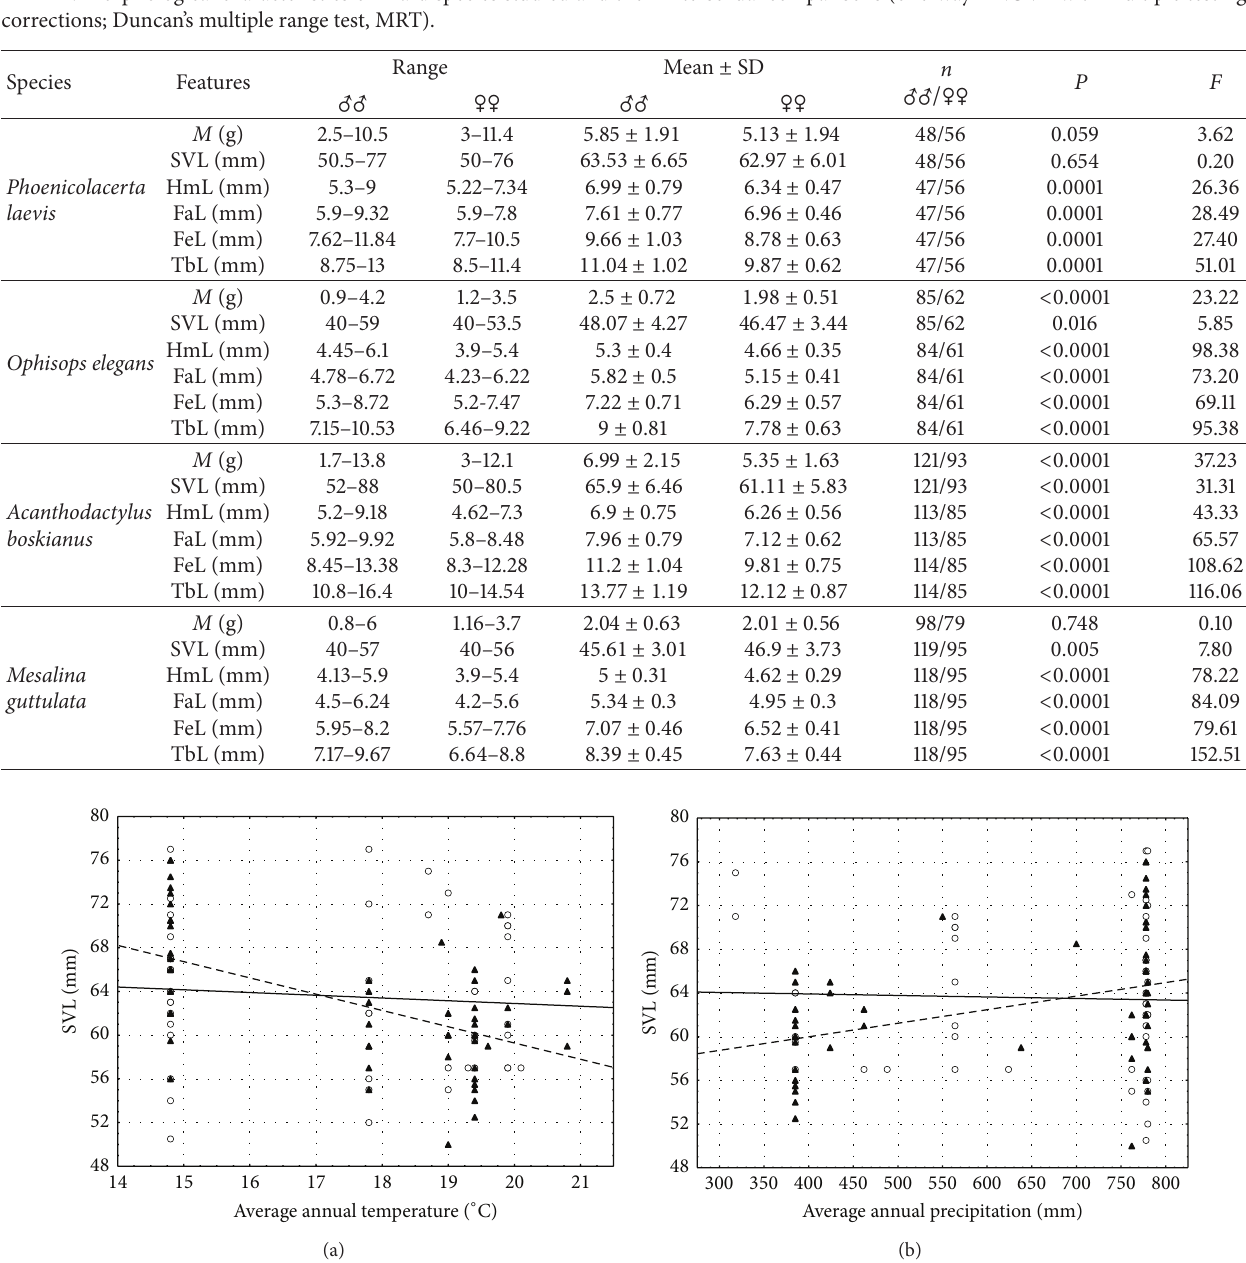
Figure 2: The relationship between SVL and (a) average annual temperature and (b) average annual precipitation in Phoenicolacerta laevis : solid line with circles: males; dashed line with triangles: